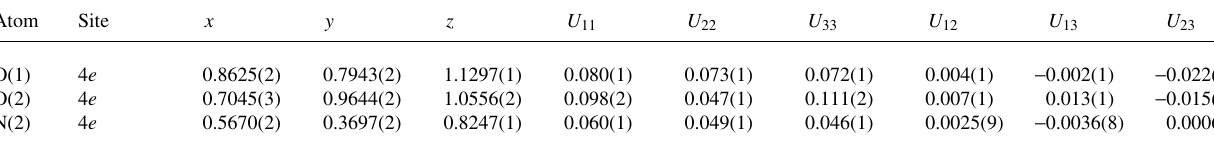
Table 3. Atomic coordinates and displacement parameters (in Å 2 )